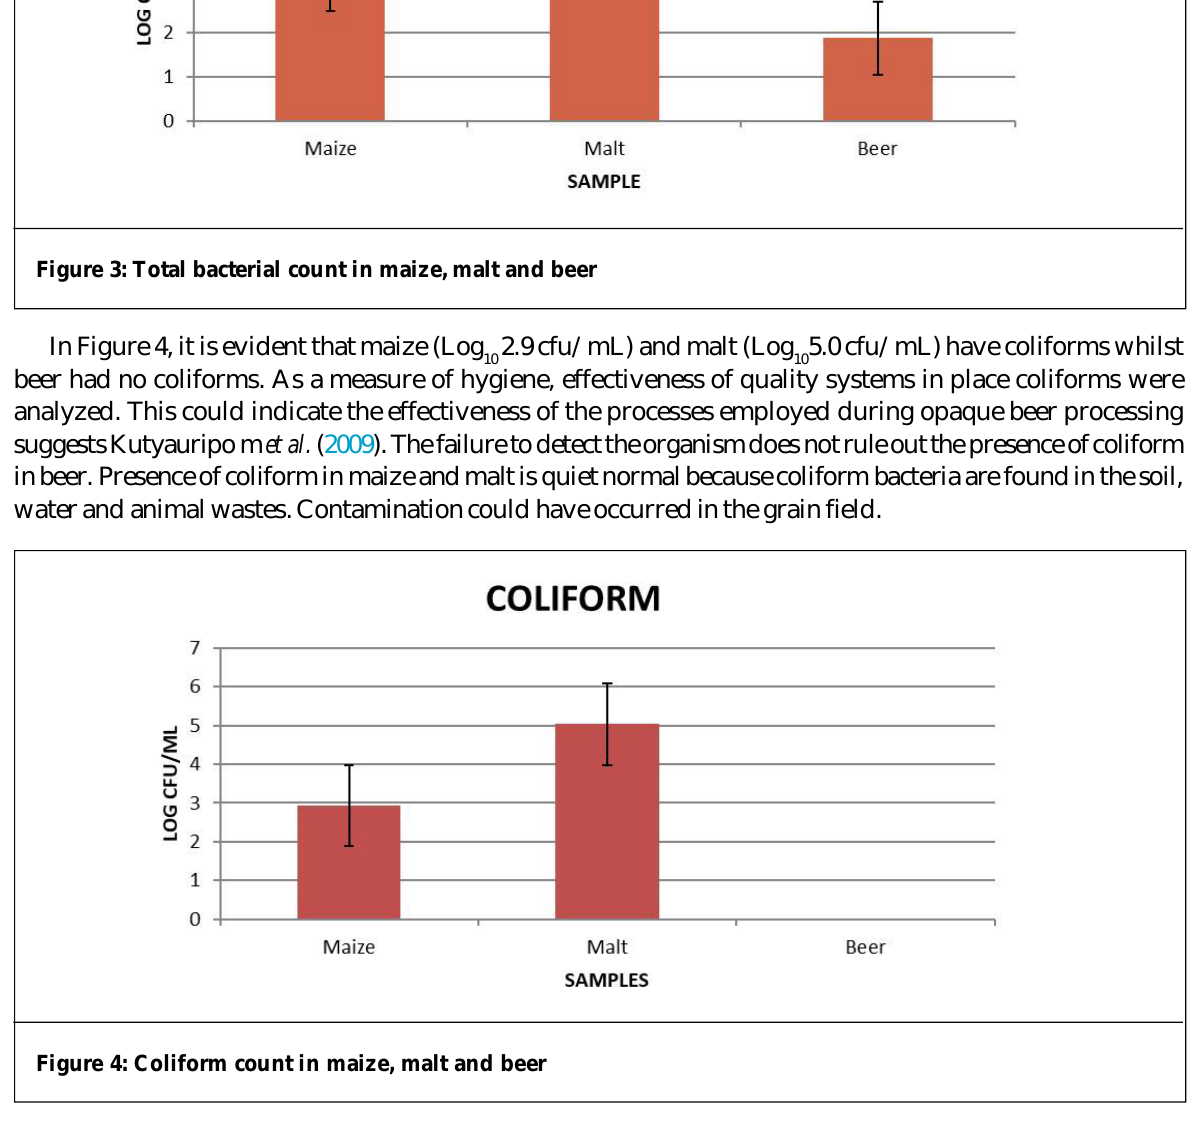
Salmonella and Shigella were detected in maize and beer this is a signal of poor handling of raw materials and final product (beer) (Table 2). They are transmitted to food through human faecal wastes and contaminated water Bokulich and Bamforth (2013). Salmonella and Shigella are pathogenic microorganisms of concern their presence in beer renders the product unsafe for human